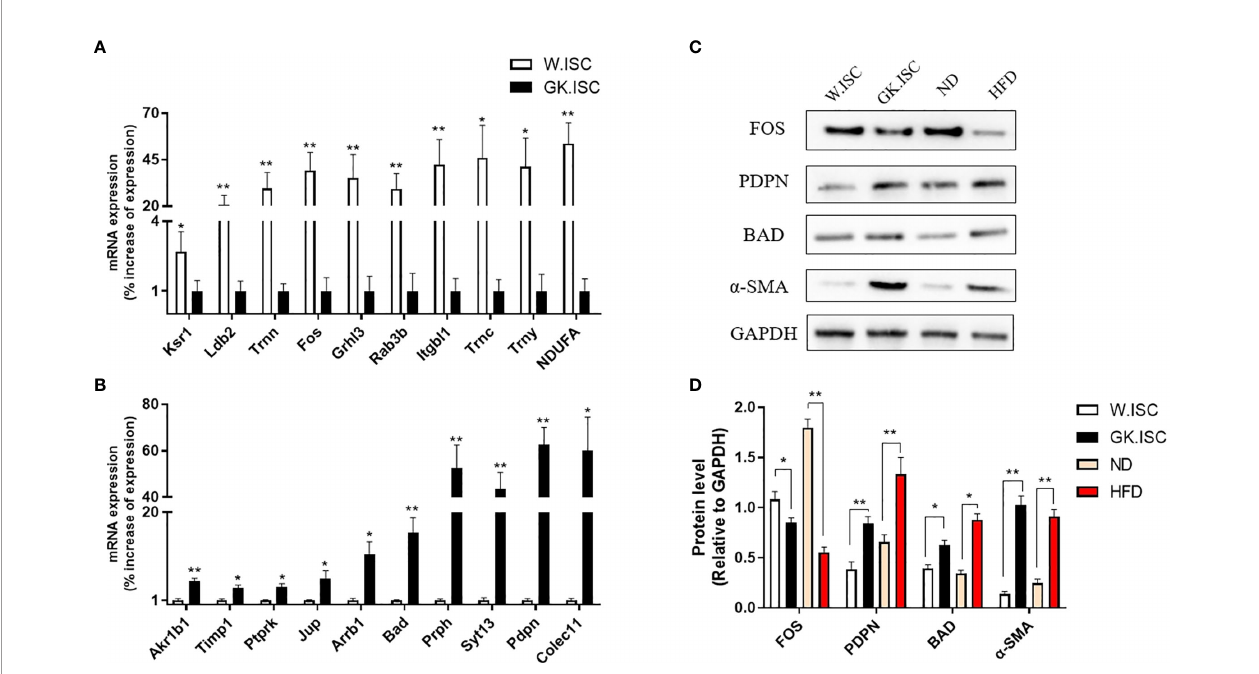
FIGURE 4 | Validation of RNA-seq. (A) To validate the 10 differential expression genes which over-expresses in Wistar ISCs by real-time PCR. Wistar ISCs compared with GK ISCs. (B) To validate the 10 differential expression genes which over-expressed in GK ISCs by real-time PCR. GK ISCs compared with Wistar ISCs. (C) Western blotting of ISCs by PDPN, FOS, Bad and a -SMA antibody in Wistar rat, GK rat, normal diet SD rat (ND) and high-fat diet SD rat (HFD). (D) Statistical analysis of the Western blotting. Data are expressed as means ± SEM (n = 3), * P < 0.05, ** P <